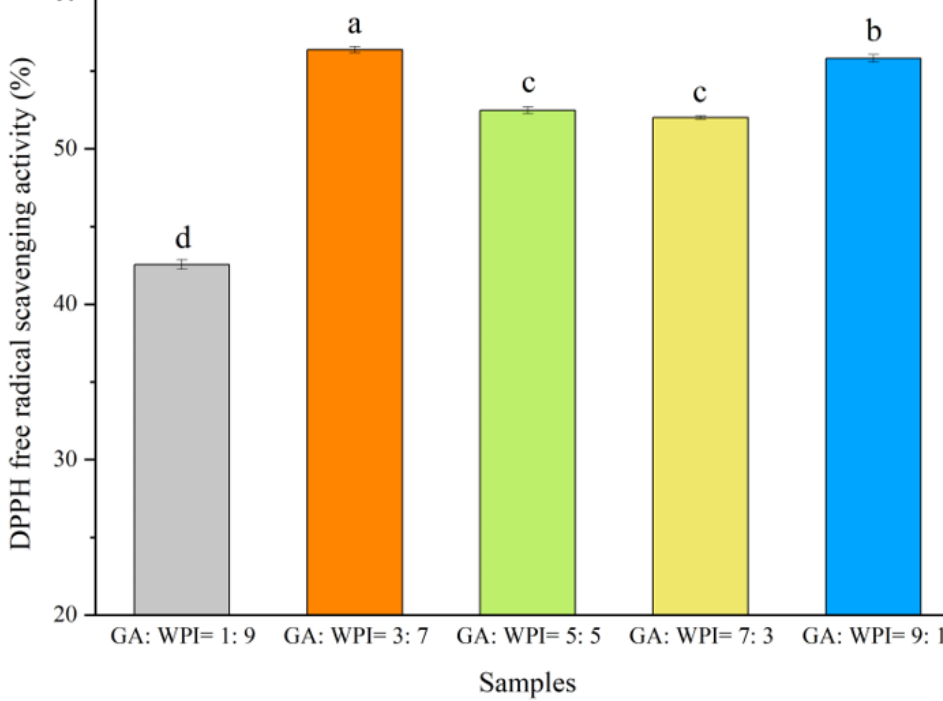
Figure 5. DPPH free radical scavenging activity (SA DPPH ) of microcapsules coated with different ratios of GA:WPI ( a–d different letters represent the significant difference from each other ( p < 0.05)).